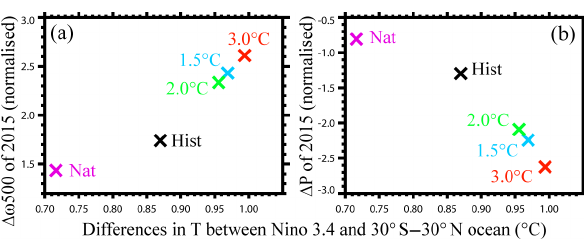
Figure 5. Relationships between Niño 3.4 warming and EA verti- cal motion and precipitation anomalies of the ensemble mean. The horizonal axes show differences in the 2015 T anomalies between the Niño 3.4 area and the 30 ◦ S–30 ◦ N ocean ( ◦ C). The vertical axes are (a) (cid:49)ω 500 (no unit) and (b) (cid:49)P (no unit) for the year 2015. Crosses denote the ensemble averages of Nat (purple), Hist (black), 1.5 ◦ C (light blue), 2.0 ◦ C (green) and 3.0 ◦ C (red). ities of (cid:49)P . The values in parentheses indicate the 10